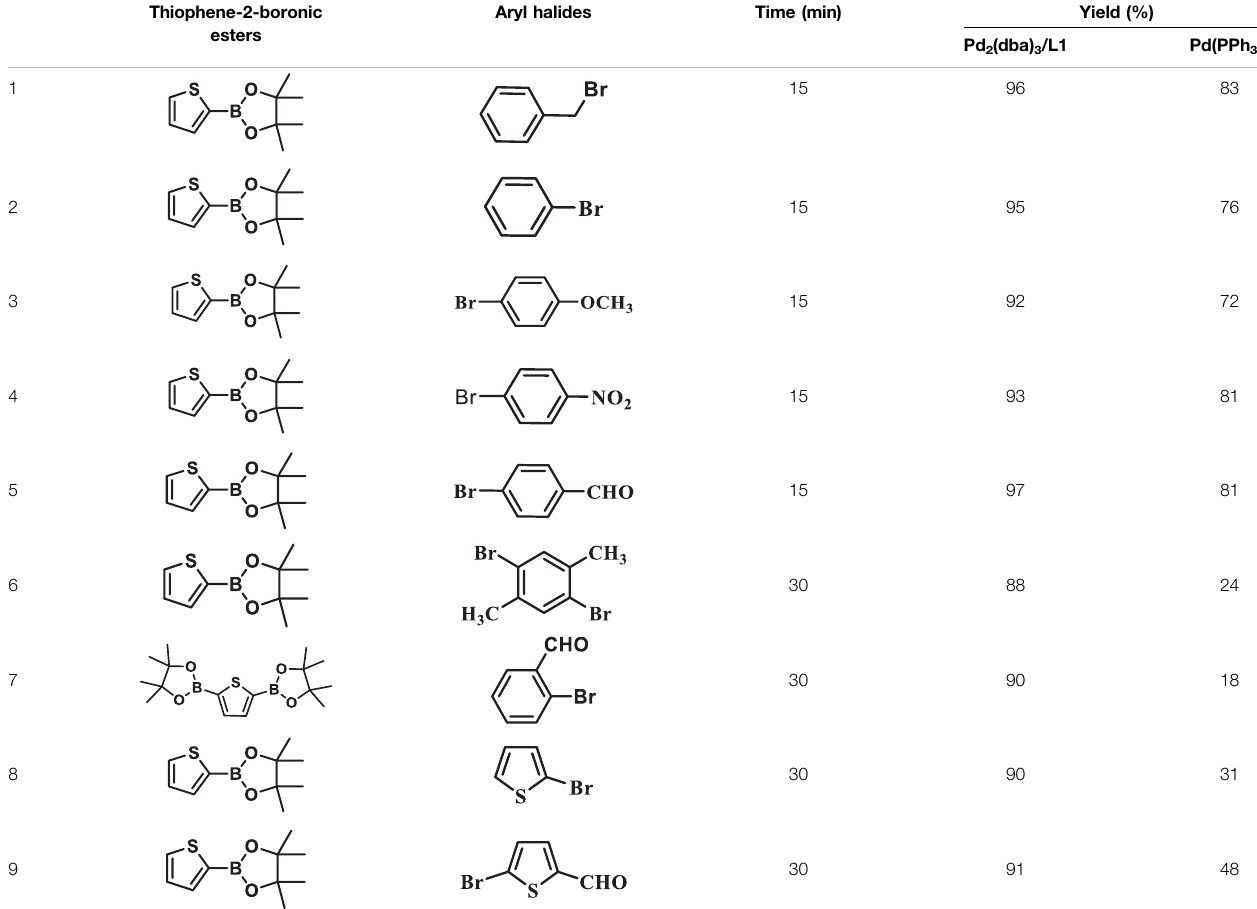
Reactionconditions:1equiv.ofthienylhalide,1or2equiv.ofthiophenylboronicester,5equiv.ofK 2 CO 3 ,THF(5 Lmol -1 ),H 2 O,0.1 mol%Pd 2 (dba) 3 +L1,re fl ux,within15 – 30 min,1 mol%